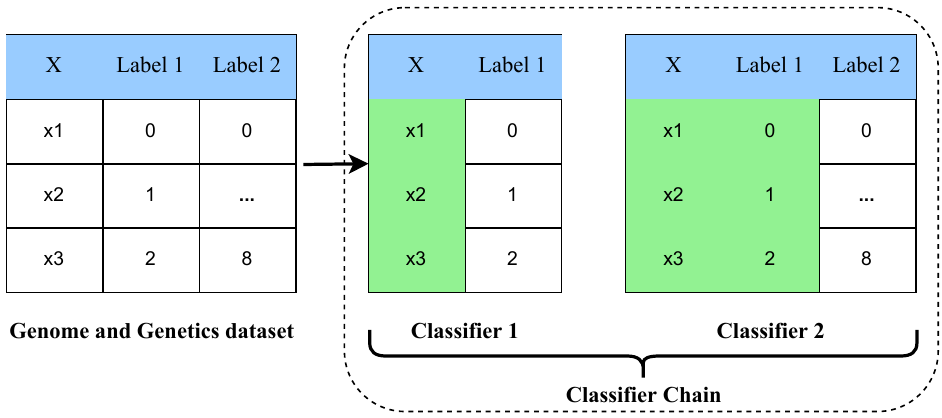
Figure 8. The architectural analysis of the multi-label multi-class classifier chain approach.